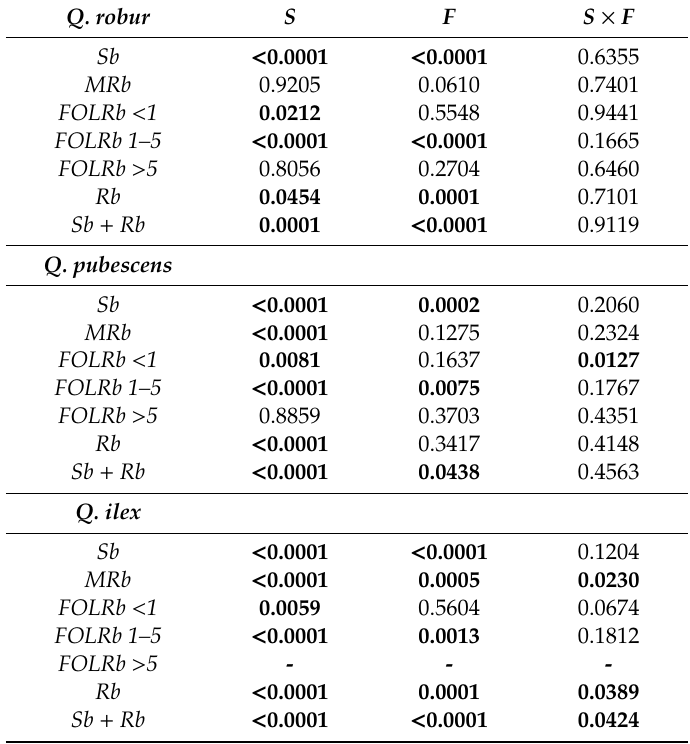
Table 3. p values from multifactorial ANOVA test results: ( p < 0.05 in bold) for seedlings biomass allocation (N obs = 20 per stocktype per species). Sources of variation—substrate ( S ), fertilization ( F ), and their interaction ( S × F ). Sb : shoot-system biomass; MRb : main root biomass; FOLRb : First Order Lateral Root biomass split by diameter class ( < 1 mm, 1–5 mm, > 5 mm); Rb : total root-system biomass; and Sb + Rb : total seedling biomass. Q.